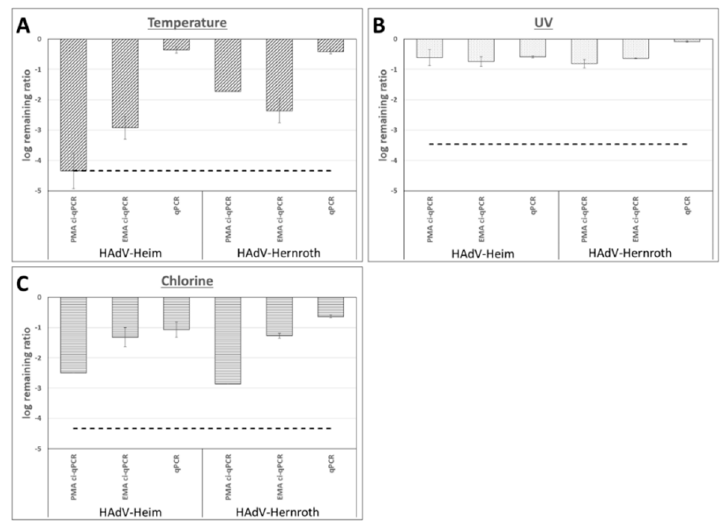
Figure 1. Log 10 remaining ratio of HAdV-Heim and HAdV-Hernroth mean values with and without ethidium monoazide (EMA) or propidium monoazide (PMA) dye pretreatment after exposure of the samples to 95 °C for 10 min ( A ), 150 mJ·cm − 2 UV-C ( B ) and 4 mg min·L − 1 free chlorine ( C ). The dotted line represents the results from cell culture and the error bars show the standard deviation. n = 8 for each inactivation condition and the